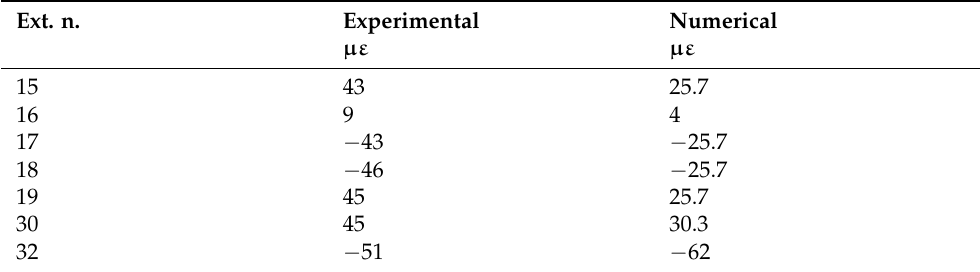
Table 4. Comparison between the experimental strain at the maximum torque along with numerical strain evaluated in the differential torsion test for a selected list of strain gauges. Ext. n.